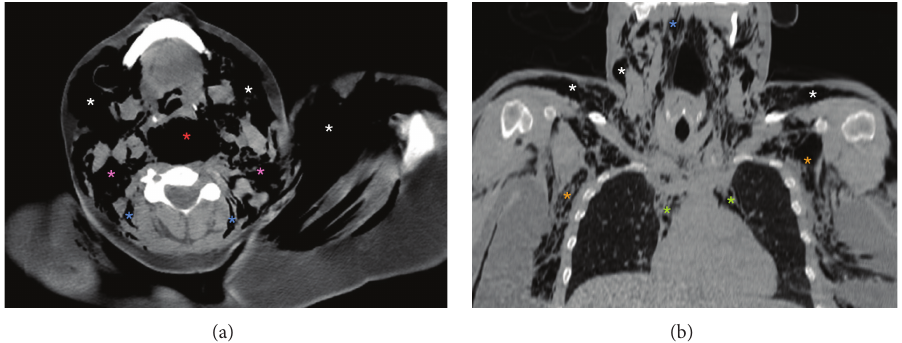
Figure 2: (a) Axial, (b)coronal cervicothoraco CT scan with 2D reconstruction obtained urgently.